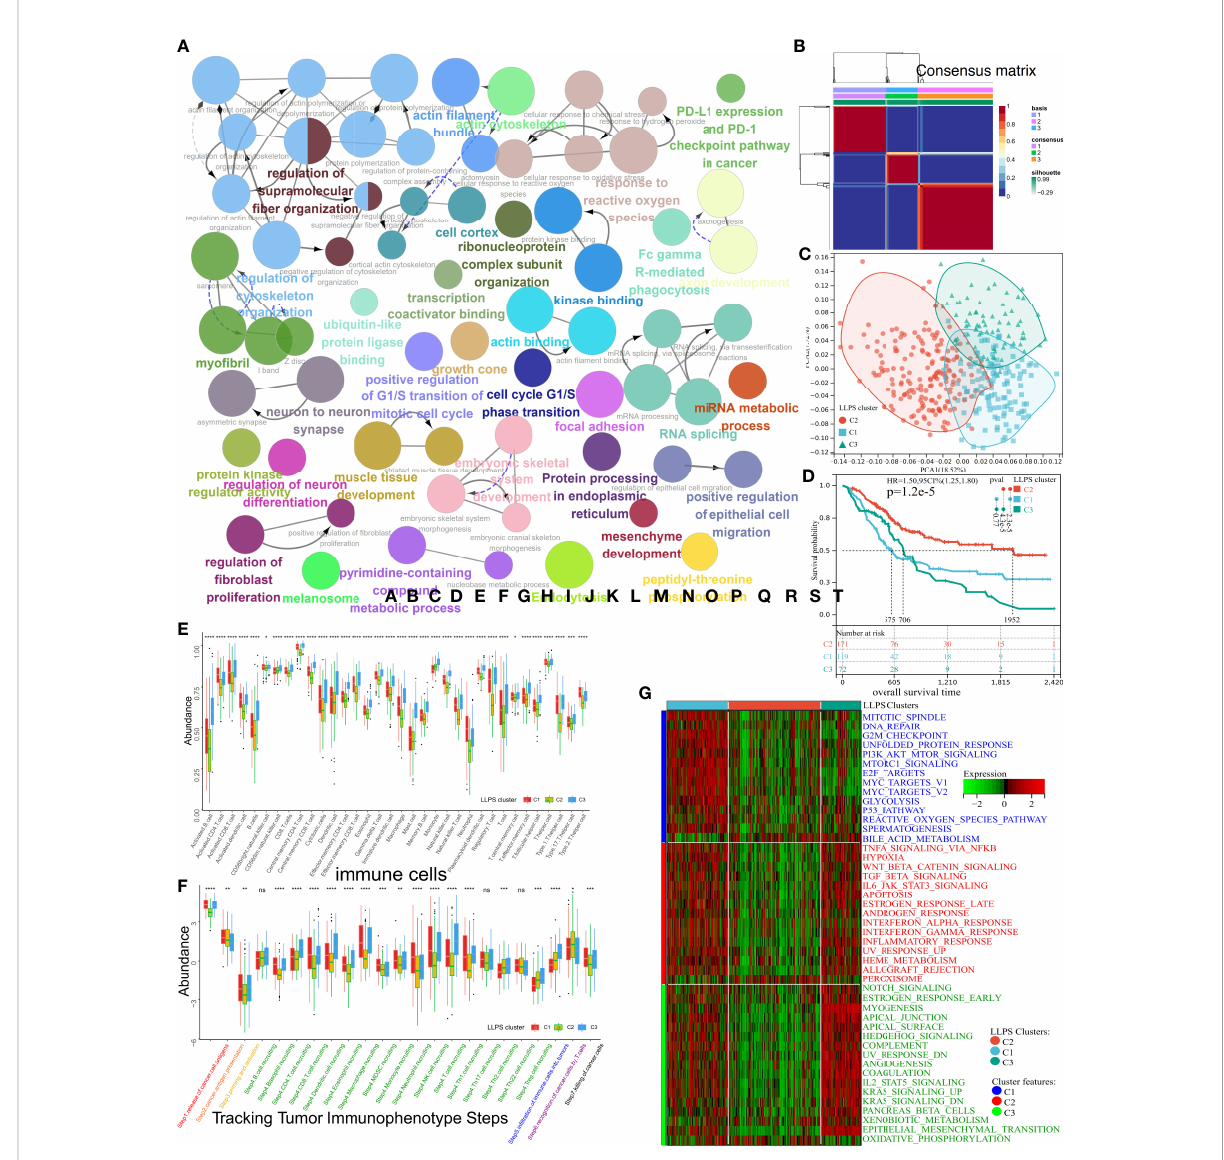
FIGURE 2 Subtype identi fi cation, TME in fi ltration characteristics, and biological signal features of three distinct LLPS clusters in BLCA. (A) The GO terms and KEGG pathway enrichment analysis of 586 prognostic LLPS-related genes. The different colors represent different terms or pathways. (B) Consensus map of NMF based on 586 prognostic LLPS-related genes when k = 3. (C) PCA plot to distinguish LLPS clusters. (D) KM curve exhibited signi fi cantly different OS among LLPS clusters in TCGA-BLCA cohort. (E, F) Differences in 34 TME-in fi ltrating cells and steps of the cancer immunity cycle among LLPS clusters. (G) Heatmap illustrated cancer hallmarks ’ enrichment among three LLPS clusters. Red represents high scores, and green represents low scores. The line in the box represents the median value, and the asterisks represent the p-value (*p< 0.05; **p< 0.01; ***p< 0.001; ****p< 0.0001); the statistical analyses were performed by the Kruskal – Wallis test. TME, tumor microenvironment; LLPS, liquid – liquid phase separation; BLCA, bladder cancer; GO, Gene Ontology; KEGG, Kyoto Encyclopedia of Genes and Genomes;